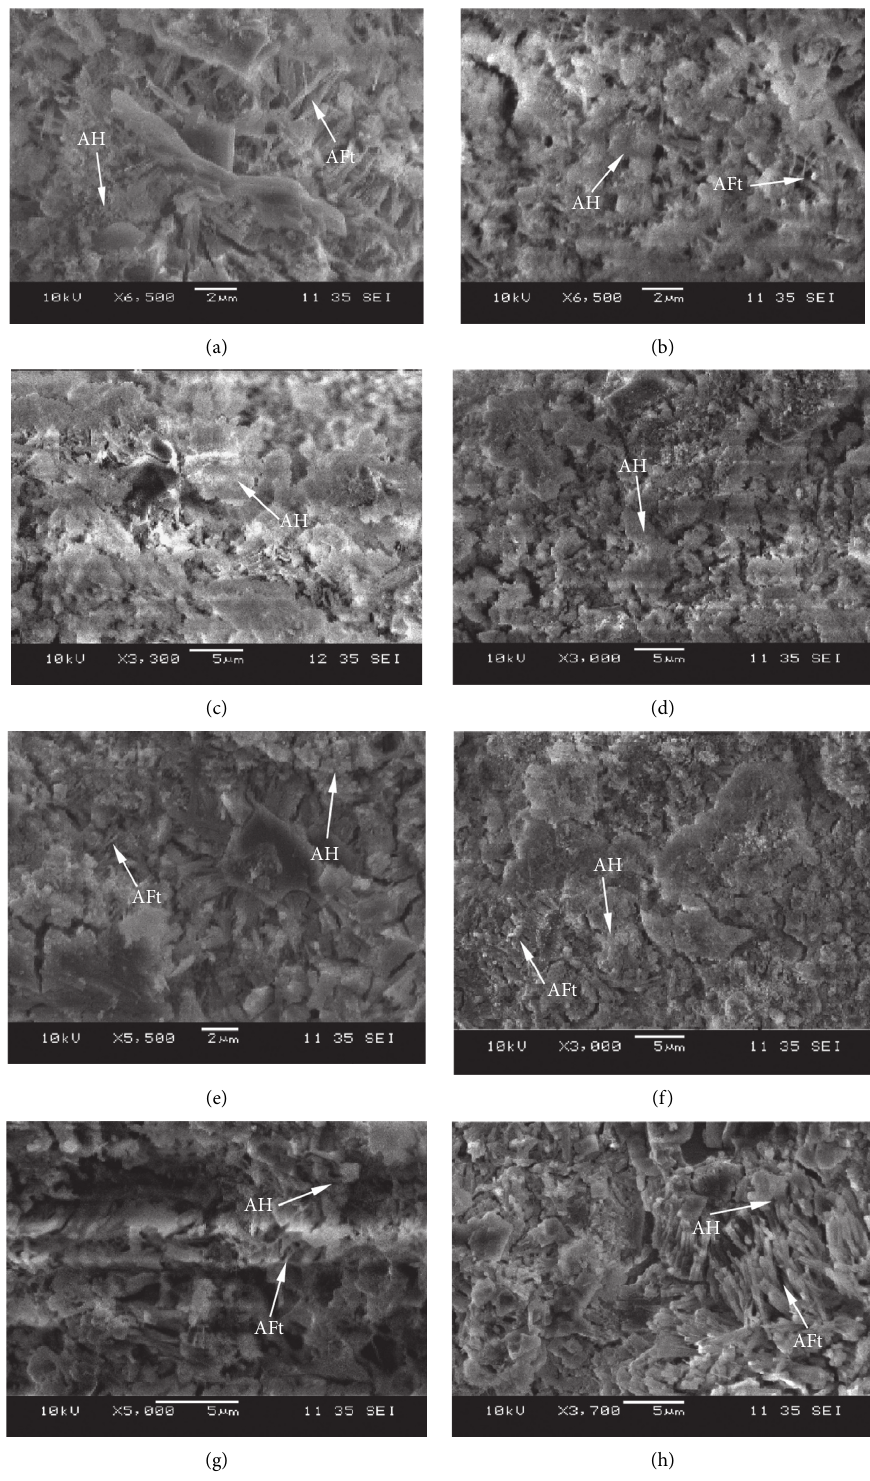
Figure 7: SEM diagrams of CSA cement mixed with different mixing water and w/c ratios. (a) Freshwater with w/c of 0.40 cured for 1d. (b) Seawater with w/c of 0.40 cured for 1d. (c) Freshwater with w/c of 0.48 cured for 1d. (d) Seawater with w/c of 0.48 cured for 1 d. (e) Freshwater with w/c of 0.40 cured for 7d. (f) Seawater with w/c of 0.40 cured for 7d. (g) Freshwater with w/c of 0.48 cured for 7d. (h) Seawater with w/c of 0.48 cured for